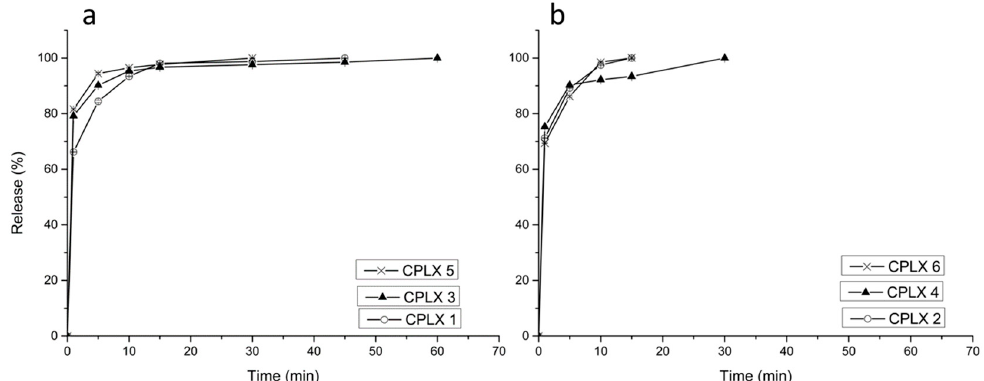
Figure 8. In vitro release of doxycycline from microparticles 1, 3 and 5 ( a ); and the same microparticles 2, 4 and 6 but